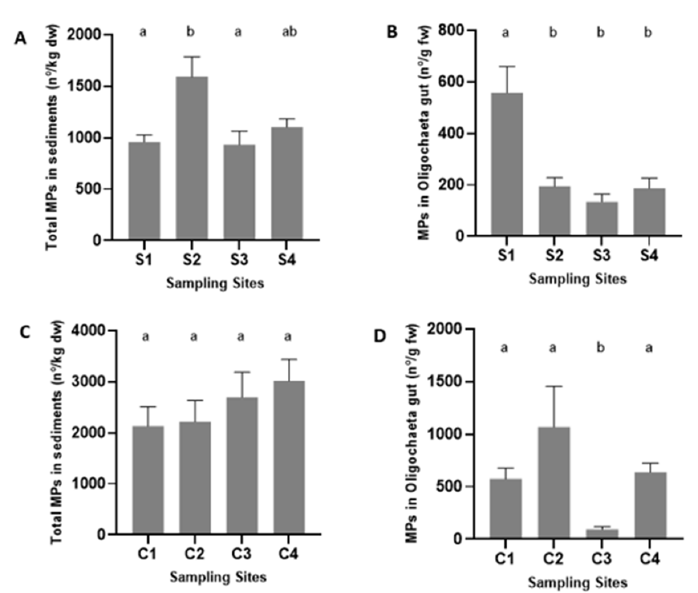
Figure 2. Total number of microplastics (MPs) found in Selho river (( A ), sediments; ( B ), Oligochaeta’s gut) and Costa-Couros river (( C ), sediments; ( D ), Oligochaeta’s gut). Data are presented as the mean ± SEM (sediment: n = 5; organisms: n = 15). Different letters indicate significant differences ( p < 0.05).